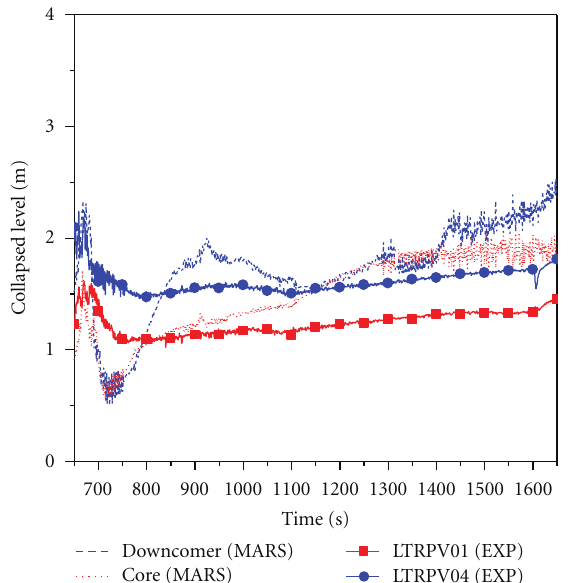
Figure 4: Comparison of measured water levels in the core and the downcomer with code calculations during LB-CL-05.